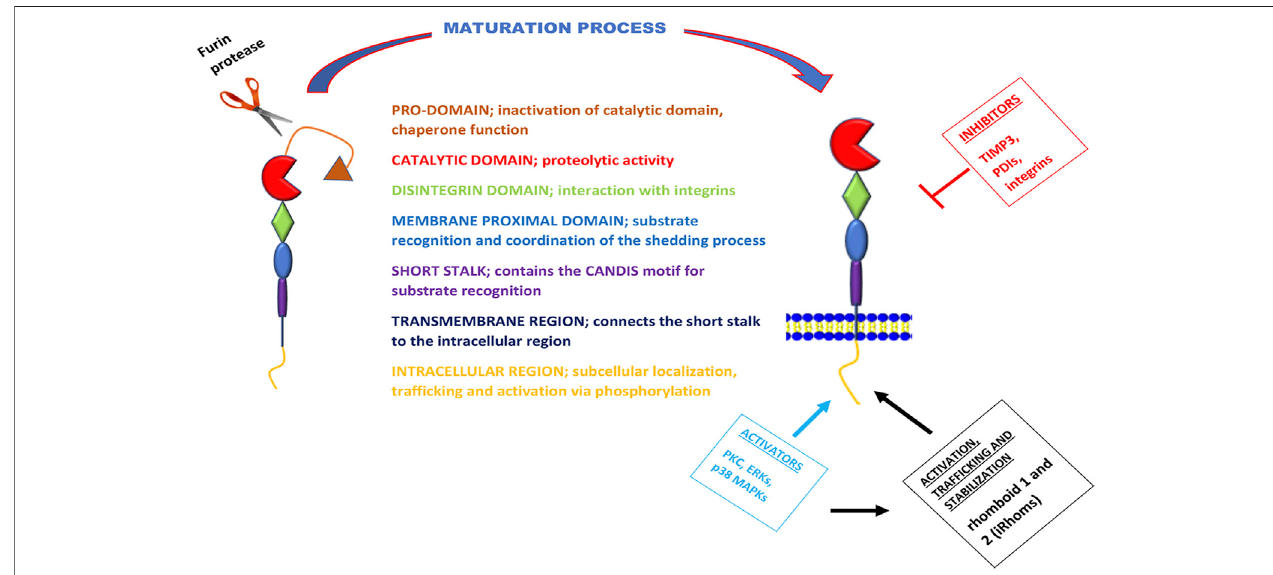
FIGURE 1 | Schematic overview of the structure, function, maturation process, and regulation of ADAM17. The metalloprotease ADAM17 can be divided into seven domains with distinct functions, here separated by different colors. During maturation of ADAM17, the pro-domain iscleaved of by furin proteases. The activation of this metalloprotease is via its intracellular region by kinases; PKC, ERKs, and p38 MAPKs. These kinases are also known to phosphorylate and activate iRhoms for traf fi cking, stabilization, and cell surface expression of ADAM17. However, the inhibition of ADAM17 is mostly carried out by TIMP3, PDIs, and integrins.